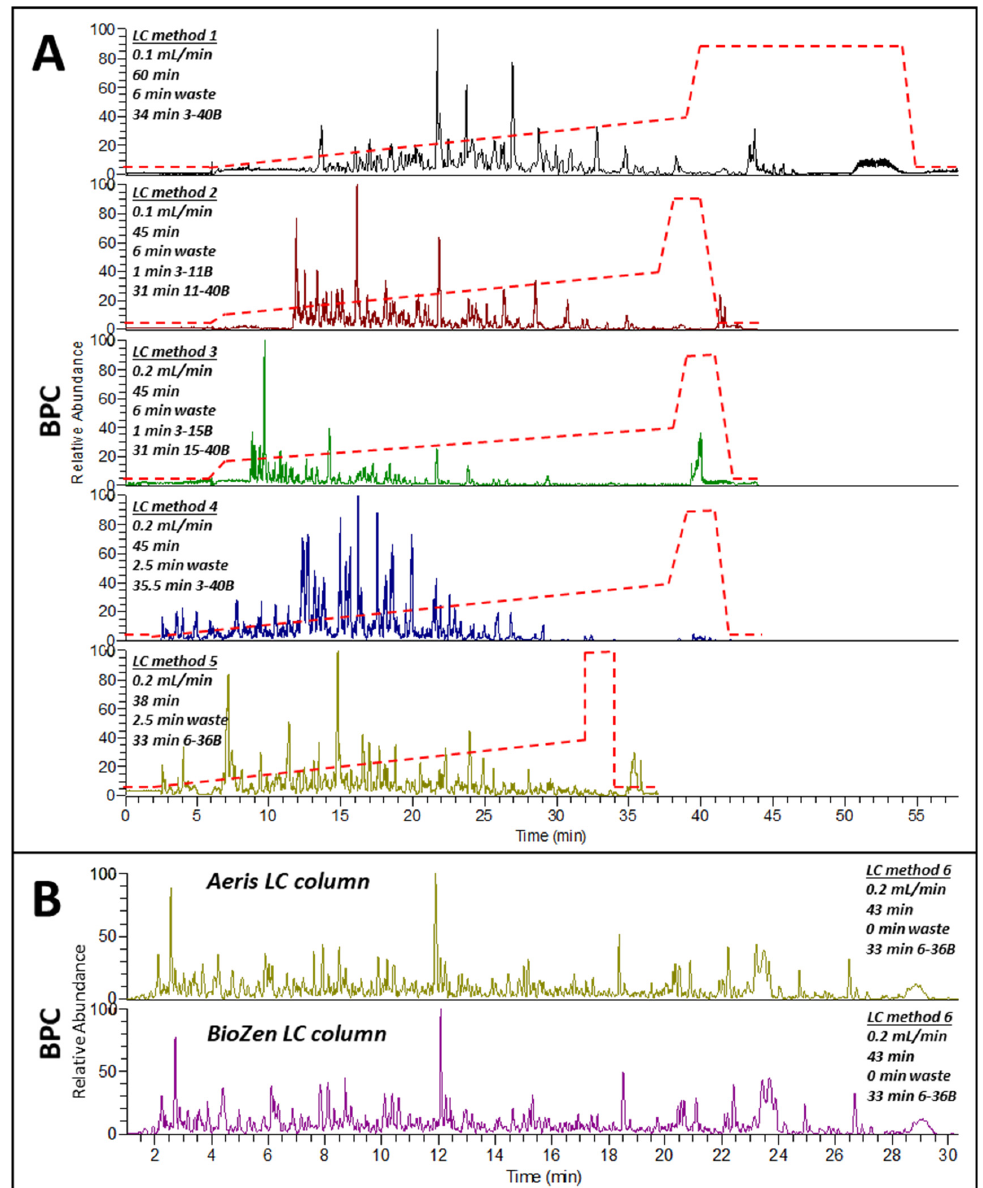
Figure 5. Testing LC separation. Twenty milligrams ( ± 0.2 mg) from LRPB Flanker) was weighed, extracted using 0.5 mL Gnd-HCl buffer, and digested using trypsin/Lys-C. LC methods are described in the Materials and Methods. ( A ) BPCs obtained to test LC durations, solvent gradients, initial online desalting durations, and flow rates; red dotted lines depict the solvent gradient; ( B ) BPCs using the LC method 6 to compare BioZen and Aeris XB-C18 LC